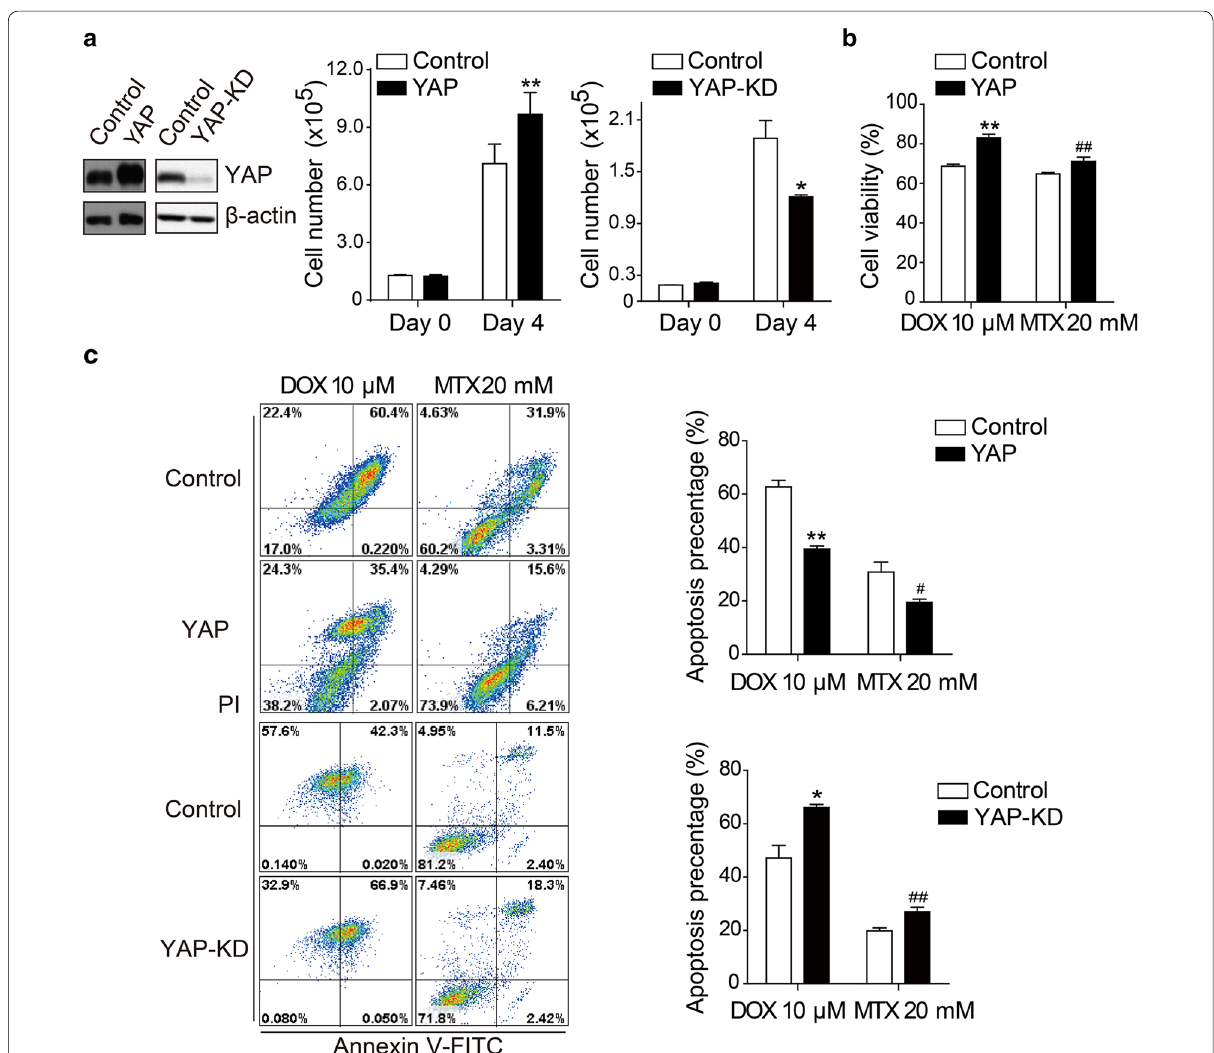
Fig. 1 Yes‑associated protein (YAP) increases the proliferation and chemoresistance of MG63 osteosarcoma cells. a Control and YAP‑overexpress‑ ing/knockdown MG63 cells were seeded at the same concentration, and cell numbers were counted every 24 h. Data are shown as mean ard deviation (SD). Compared with control ( t test, n 3), ** P < 0.01, and * P < 0.05. Results show that overexpression of YAP accelerated MG63 cell = proliferation and knockdown of YAP decreased cell proliferation. b Cell viability was analyzed by detecting total cellular adenosine triphosphate in methotrexate (MTX) (20 mM)‑ or doxorubicin (DOX) (10 μM)‑treated control and YAP‑overexpressing MG63 cells. Data are shown as mean Compared with control ( t test, n 3), ** P < 0.01, and ## P < 0.01. Overexpression of YAP increased the viability of MG63 cells treated with MTX = (20 mM) or DOX (10 μM). c Left panel representative images of flow cytometry analysis of YAP‑overexpressing and YAP‑knockdown MG63